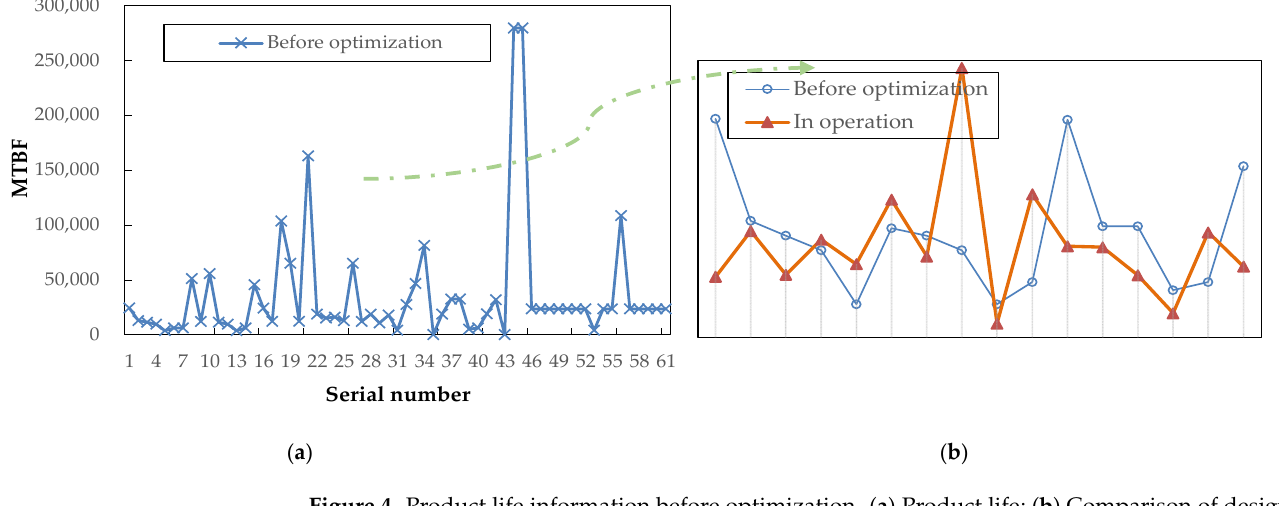
Figure 4. Product life information before optimization. ( a ) Product life; ( b ) Comparison of design and operating life.